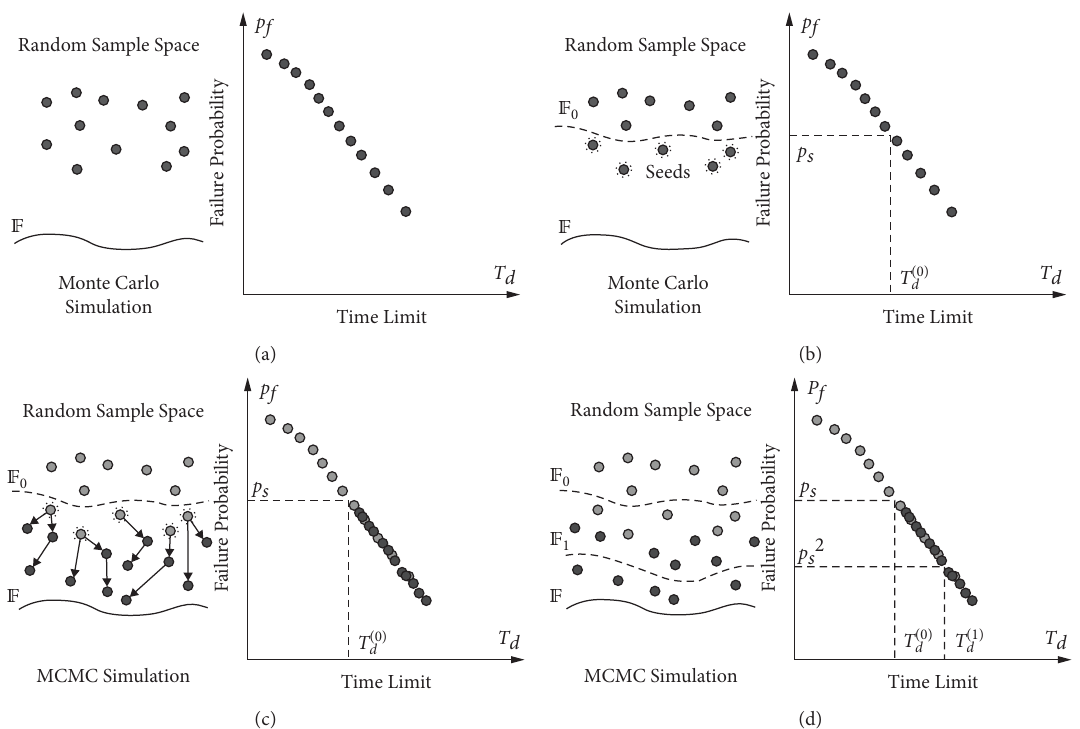
Figure 1: Illustration of subset simulation procedure. (a) Iteration 1: Direct Monte Carlo Sampling. (b) Iteration 1: Seed Selection. (c) Iteration 2: MCMC Sampling using seeds. (d) Iteration 2: Seed Selection.